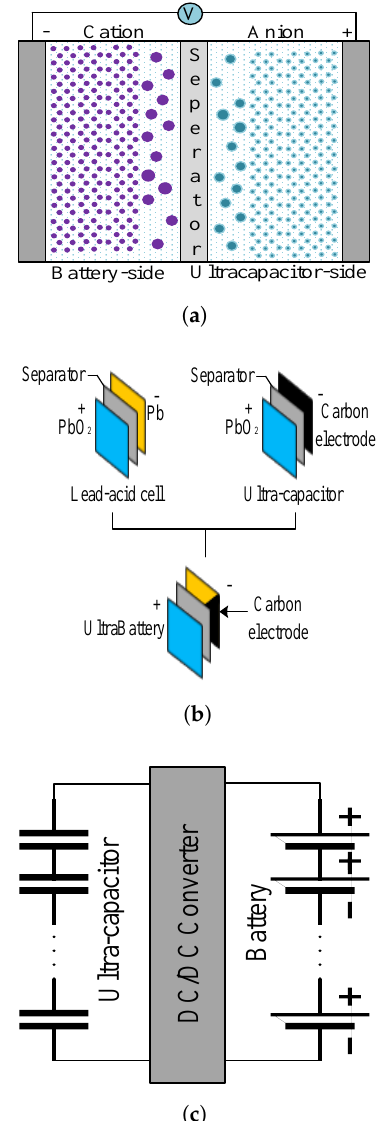
Figure 12. Possible approaches for hybridizing ultra-capacitors and batteries. ( a ) Internal hybridization, ( b ) Ultrabattery ( c ) External